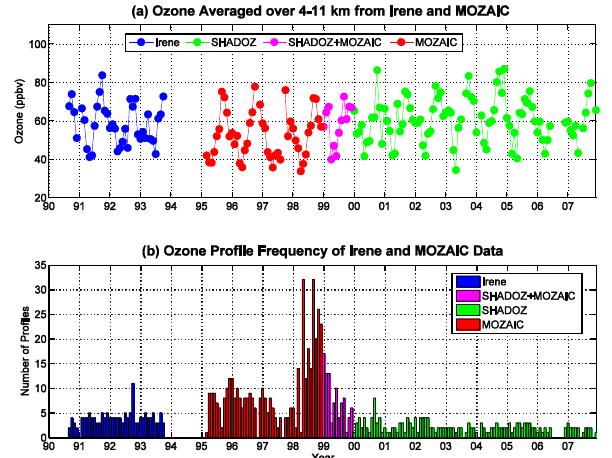
Figure 7. Trend (change in %decade − 1 ) computed from multivari- ate regression model for combined 4–11km, Irene–JNB MOZAIC profile data, 1990–2007. Diagonal shading denotes statistical sig- nificance. Increases below 5km may be related to surface